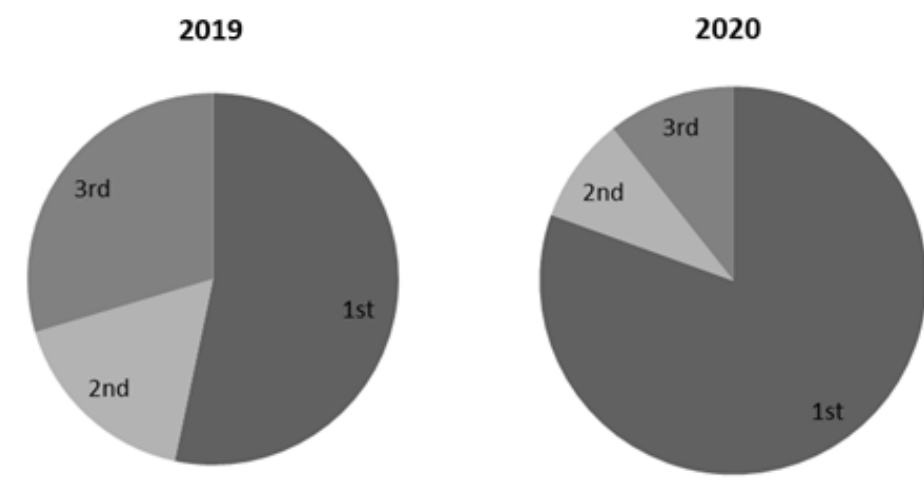
Figure 3. Distribution of different generation of cefalosporins consumption in 2019 and 2020.